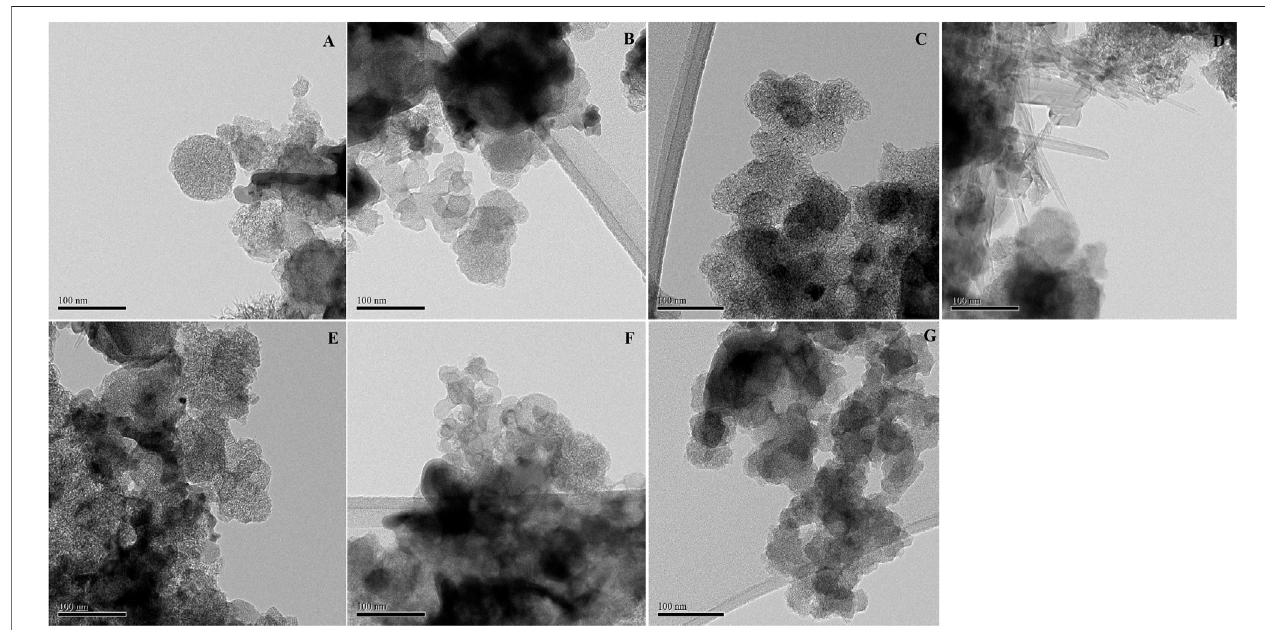
FIGURE5| Morphology ofdifferentNiMo/OCP f catalysts (A) 2.5wt%Ni13wt%Mo/OCP f (B) 2.5wt%Ni19wt%Mo/OCP f (C) 3.5wt%Ni13wt%Mo/OCP f (D) 3.5wt% Ni19wt%Mo/OCP